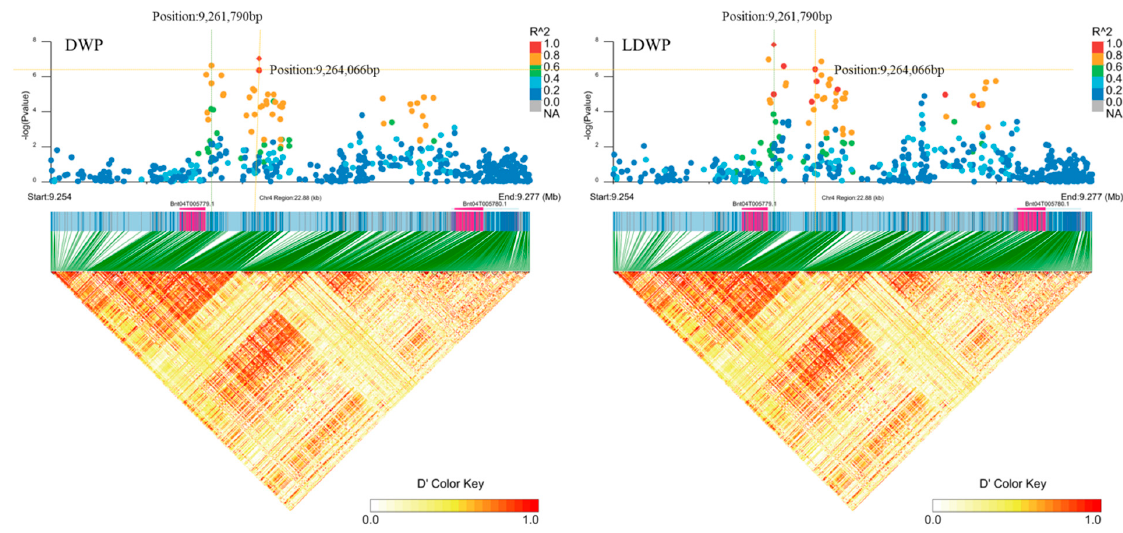
Figure 11. Candidate genes for DWP (dry weight per plant) and LDWP (leaf dry weight per plant) on chromosome 4. Manhattan plot (top) and linkage disequilibrium heatmap (bottom) of genomic region surrounding Bnt05G007759 . A significant signal was associated with DWP (left) and LDWP (right) on chromosome 14, as assessed using EMMAX (Efficient Mixed-Model Association eXpedited), and it was between Bnt04G005779 and Bnt04G005780 . Besides, there is another significant signal associated with DWP (left) and LDWP (right) on chromosome 14, the signal is on Bnt04G005779 . The graph shows genomic positions ( x axis) and the respective significance expressed as − log 10 p value ( y axis). The genomic position spans ~23 kb on either side of the peak SNP (single nucleotide polymorphism), indicated by orange and green dashed vertical line. The larger the R^2 (Coefficient of correlation) values (indicated in the legend on the top right), the stronger the degree of association. The red diamond indicates the associated SNP, and the lighter colors of the remaining markers reflect their successively lower R^2 values. D’ represents the correlation between different loci, the larger the value, the stronger the correlation and the higher the degree of linkage disequilibrium. The heat map showed that there was a strong linkage between the regions 9.254–9.277 Mb.